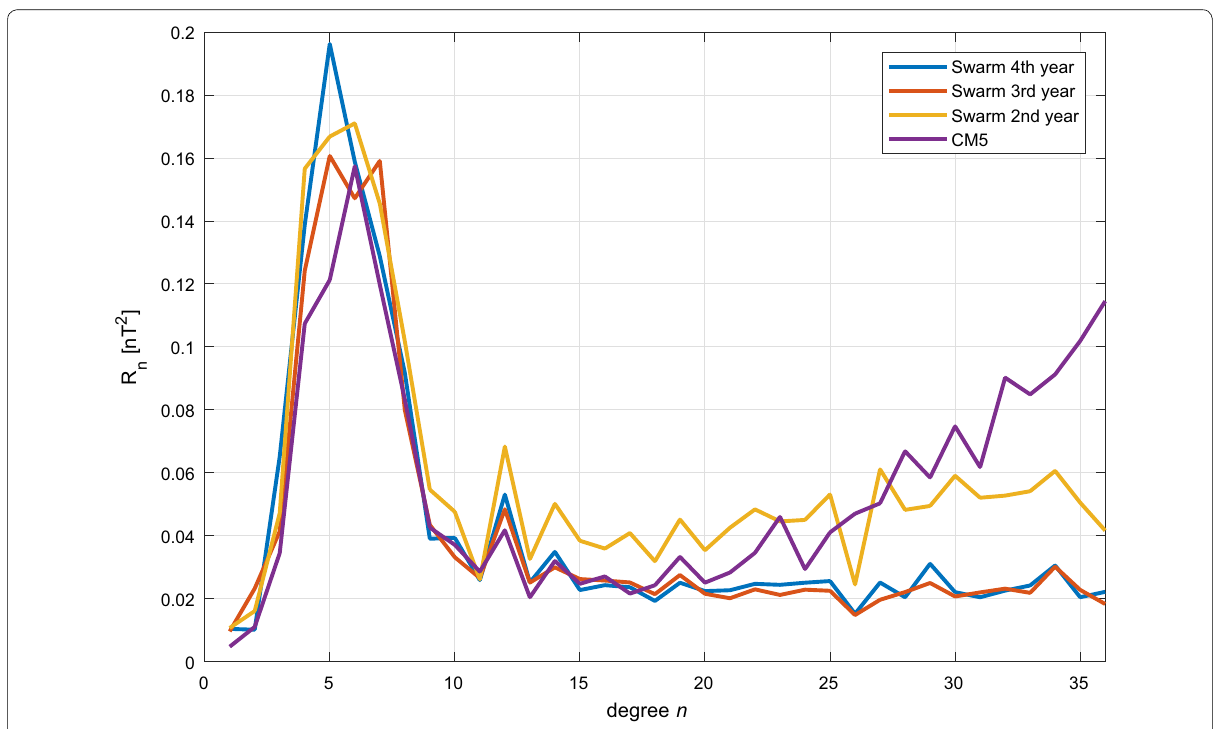
Fig. 9 The R n ( a ) spectra (Lowes 1966; Sabaka et al. 2015, 2016) of the time‑averaged oceanic M 2 tidal magnetic field at a = 6371.2km for SH degrees n = 1 − 36 from models determined by 2, 3, and 4 (CIY4) years of Swarm data and from CHAMP data (CM5)